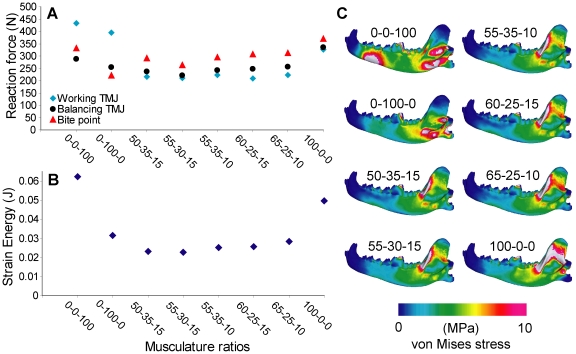
Sensitivity test on musculature ratio.
A. Ratio plotted against reaction force. B. Ratio plotted against strain energy. C. von Mises stress distribution in the working-side dentary in test models. Ratios are given by temporalis-masseter-pterygoid sequences, with zygomaticomandibularis considered part of the masseter group.